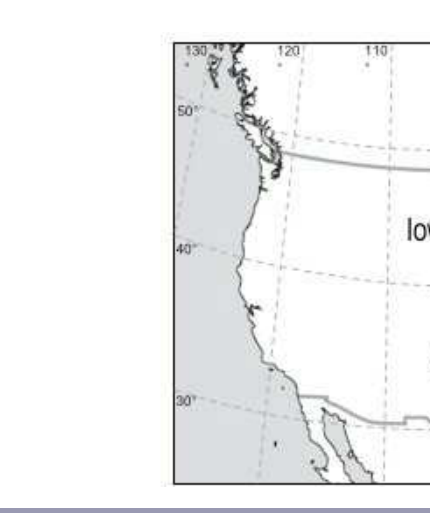
Fig. 1. The state of Iowa and the Corn Belt agroecoregion within North